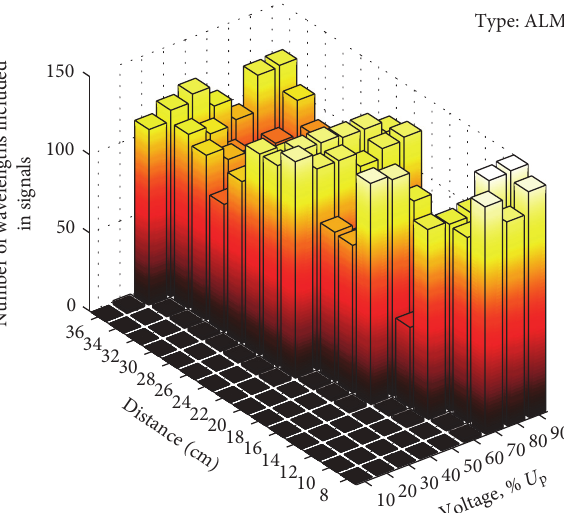
Figure 8: Dependency of voltage and distance on the value of energy of signal calculated for optical spectra emitted by corona around the MIG308LSi line.